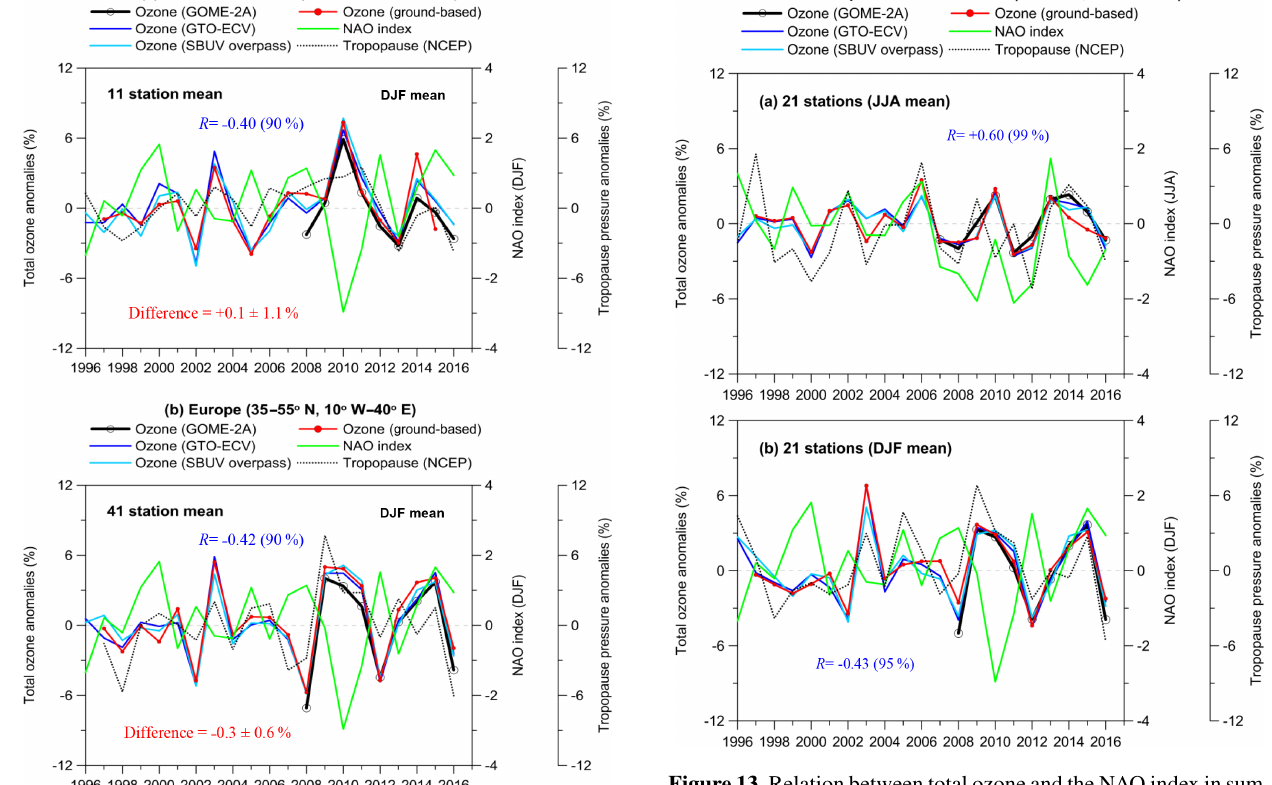
Figure 13. Relation between total ozone and the NAO index in sum- mer (JJA mean) and winter (DJF mean) for 21 stations in southern Europe. The correlation coefficients refer to NAO index and GB to- tal ozone after removing variability related to the seasonal cycle, QBO, solar cycle, and